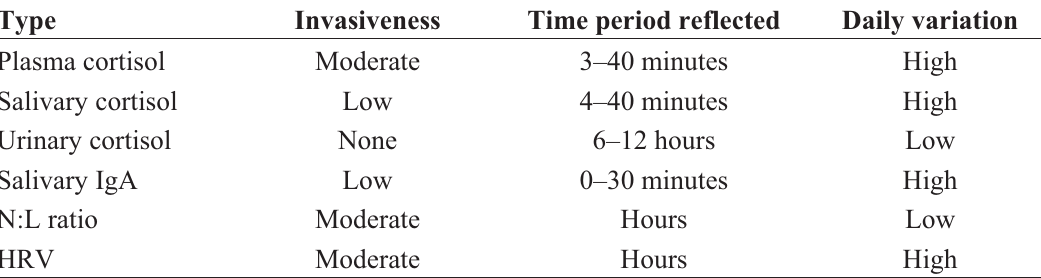
Table 1. Physiological measurements of stress in